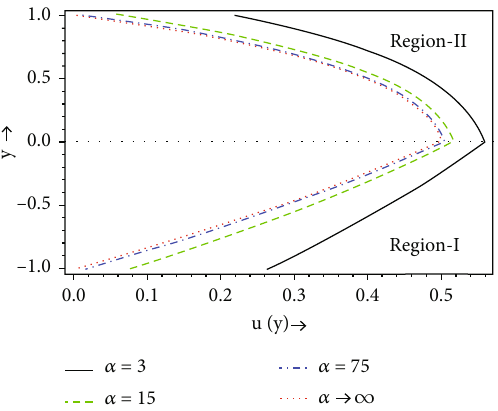
= α Þ on velocity 1 2